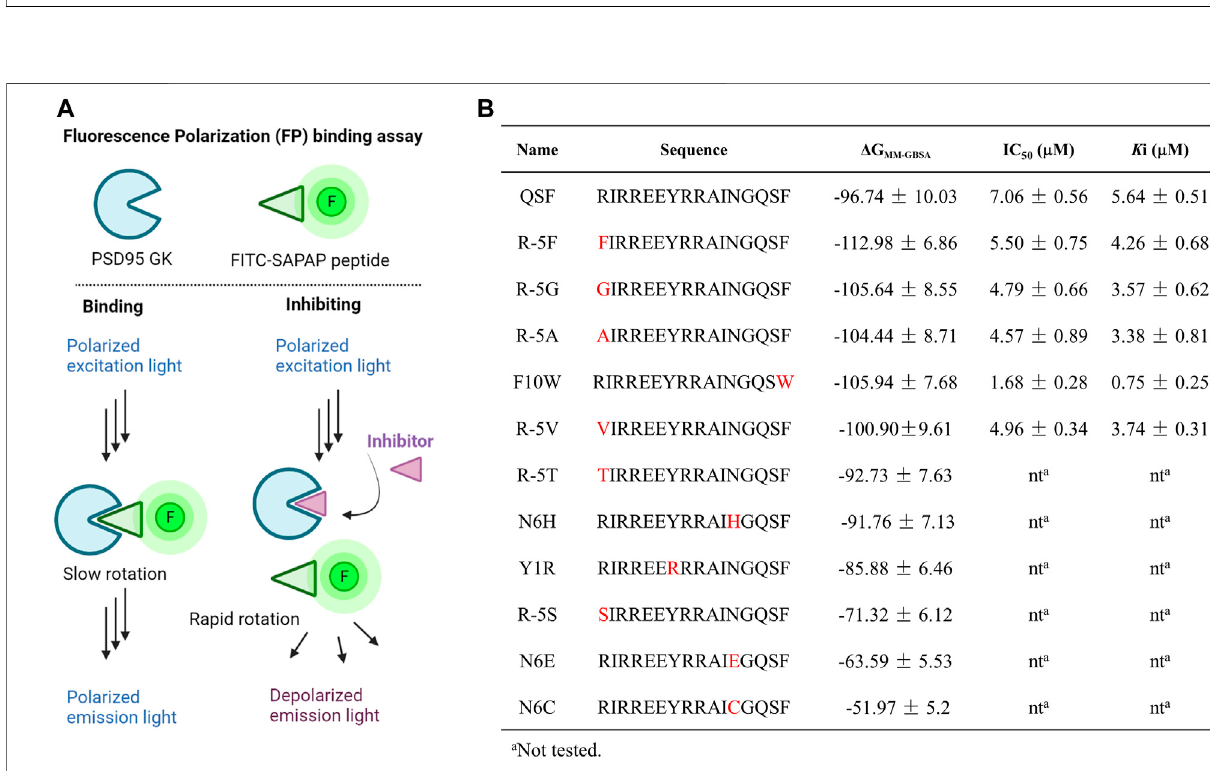
FIGURE 3 | (A) Diagrams of the FP assay con fi gurations in the PSD95 GK/FITC-SAPAP system. PSD95 GK binds the FITC-labeled SAPAP peptide, resulting in a high FP signal with polarized emission light; however, competition with inhibitors displaces FITC-SAPAP and reduces the measured polarization with depolarized emission light. (B) Binding free energy calculated by the MM-GBSA method and the IC 50 values were determined by FP assay.